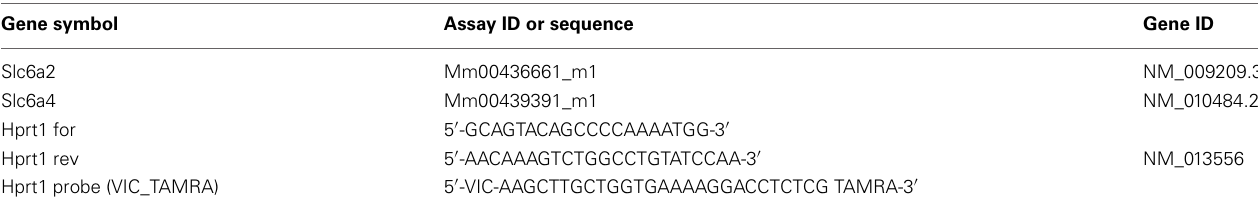
Table 1 | The taqman assays and probes used in the study. Gene symbol Assay ID or